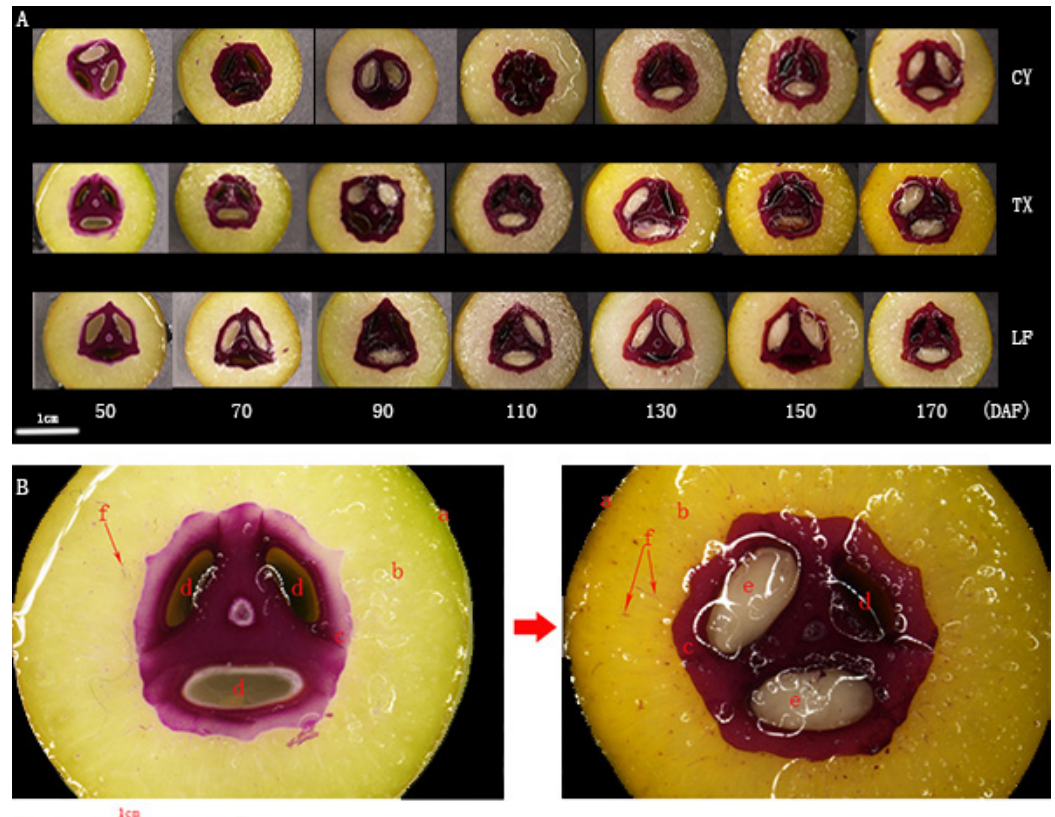
Figure 4. Lignin staining in fruit flesh of Chinese olive at different developmental stages. ( A ) CY, ‘Changying’, TX, ‘Tanxiang’, LF, ‘Lingfeng’. DAF, days after flowering. ( B ) a, exocarp; b, mesocarp; c, endocarp (color reaction of phloroglucinol-hydrochloric acid); d, seed room; e, seed; f, vascular bundle (color reaction of phloroglucinol-hydrochloric acid). The left image: 50 DAF (the stage of fruit pulp filling and core hardening), and the right image: 170 DAF (the stage of fruit maturity).